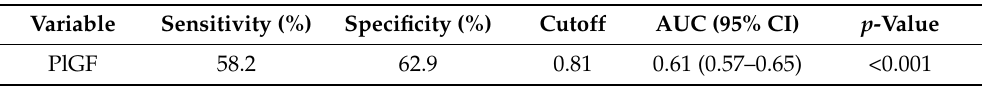
Table 3. Sensitivity, specificity, cutoff value, and area under the curve (AUC) of PlGF in the prediction and diagnosis of thyroid